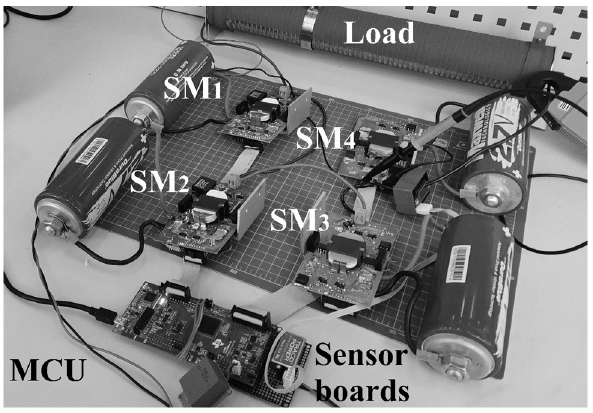
Figure 15. Complete MMC prototype.